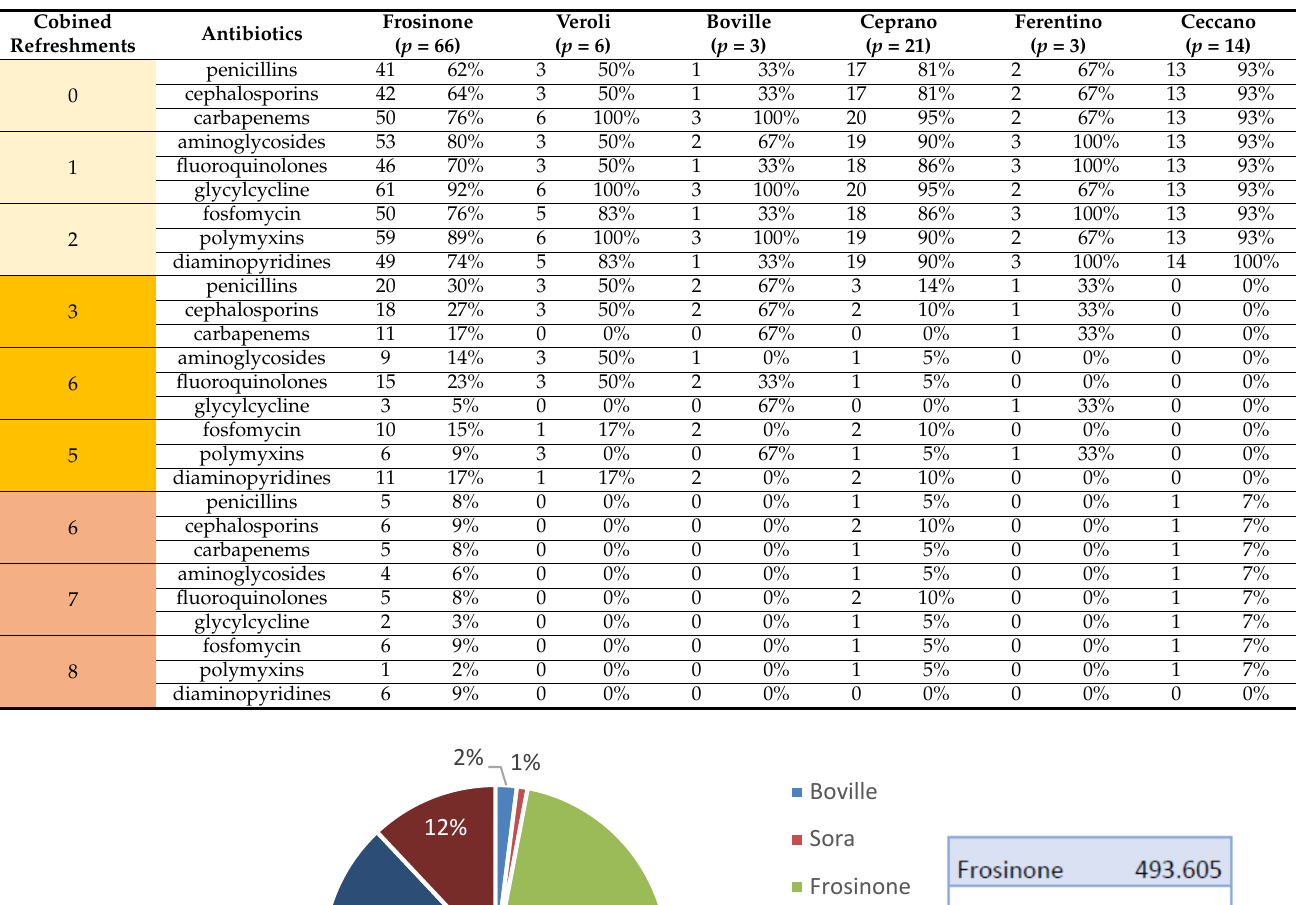
Table 2. Province of origins of the multi-resistant external patients in the period between 1 April and September 2016 (from the database described in Section 2.2).